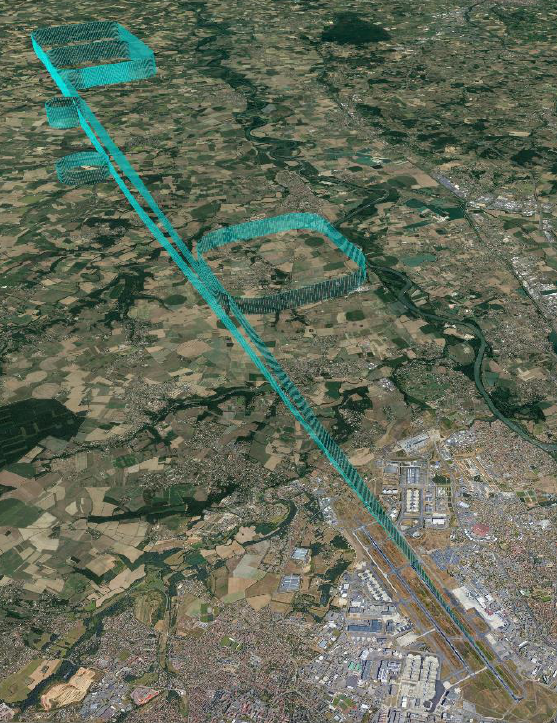
Figure 1. Flight scenario. The blue color indicates the trajectory that the participants had to follow.